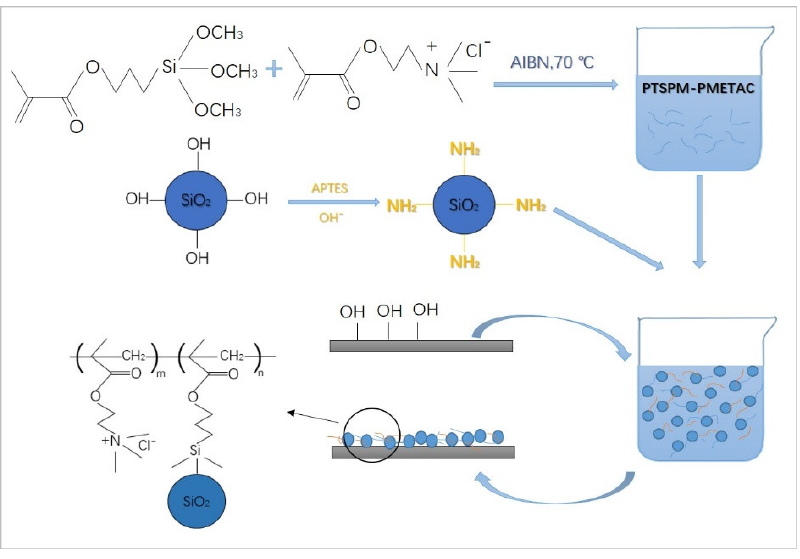
Figure 1. Preparation process of ion-responsive superhydrophobic paper.